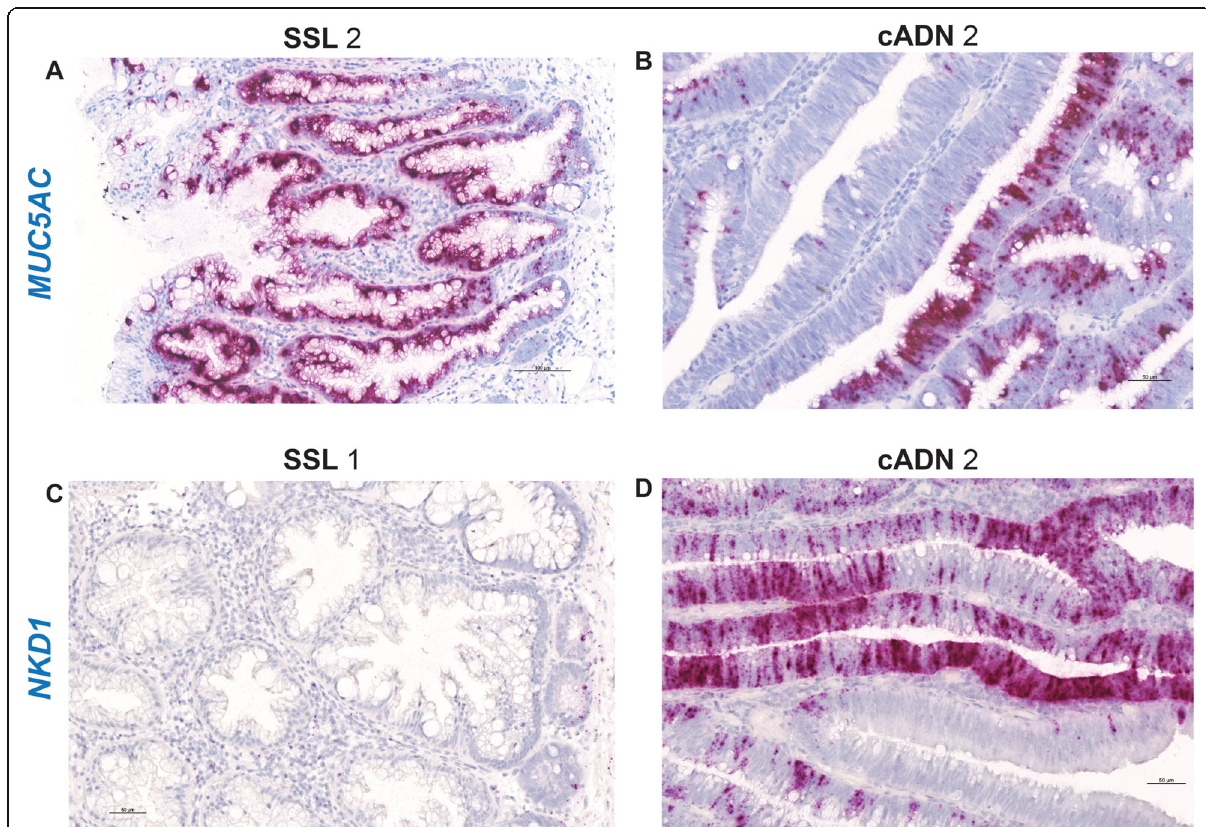
Fig. 5 In situ hybridization analysis of MUC5AC and NKD1 mRNAs in SSLs and cADNs. MUC5AC is not a specific marker of SSLs as suggested by RNA-sequencing data: it is very highly expressed also in cADNs, although less extensively than in SSLs (i.e, patchy staining). NKD1 is very highly expressed in cADNs, but not in SSLs with the exception of a few cells at the bottom of their serrated glands. Details on the expression patterns of MUC5AC and NKD1 mRNAs in the investigated lesions and in normal mucosa are shown in Supplementary Figs. 13 and 14, respectively,